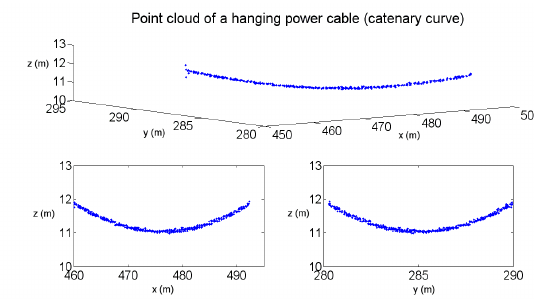
Figure 2. Real catenary point cloud (x-y-z, z-x, z-y)